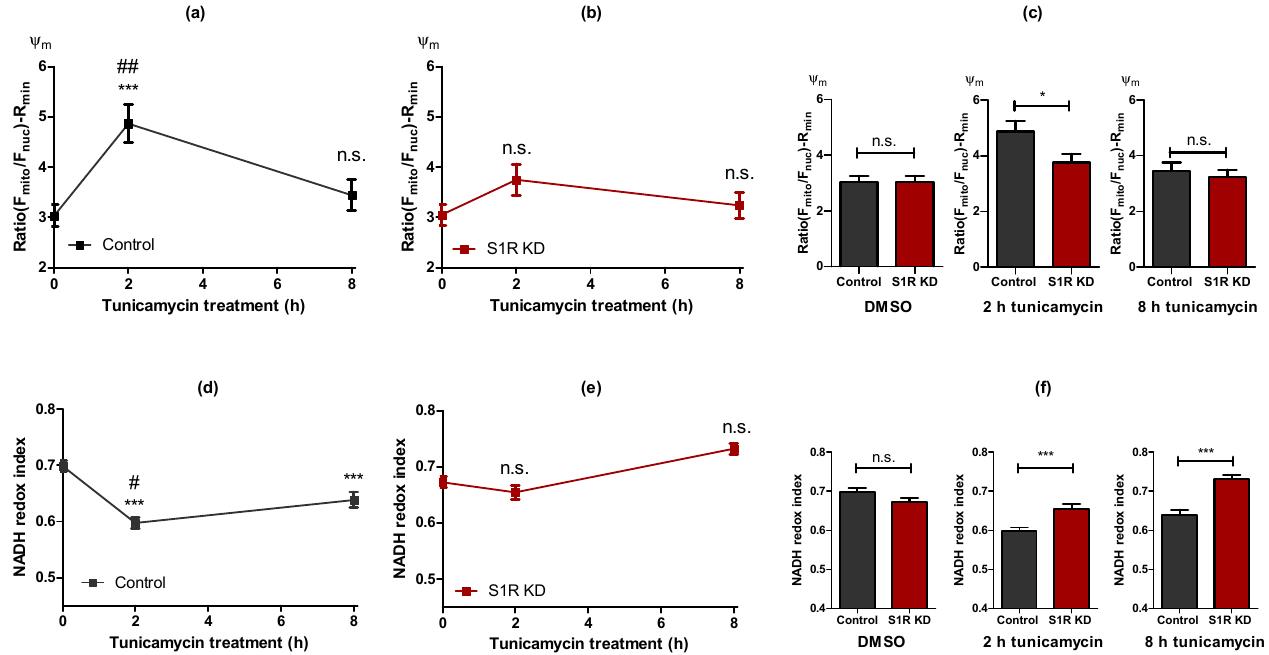
Figure 3. Alterations in the mitochondrial bioenergetic status are largely dependent on S1R during early ER stress. Time course of Ψ m after tunicamycin treatment, presented as mean ± SEM and assessed by the mitochondrial to nucleus TMRM fluorescence ratio in control SH-SY5Y cells ( a ) and in cells with S1R KD ( b ). Bar graphs represent MEAN ± SEM of Ψ m in control (black) and S1R KD (red) cells before tunicamycin treatment (left), after 2 h (middle), or 8 h (right) tunicamycin treatment ( c ). Time course of NADH redox index after tunicamycin treatment, presented as MEAN ± SEM and assessed NADH autofluorescence in control SH-SY5Y cells ( d ) and in cells with S1R KD ( e ). Bar graphs represent MEAN ± SEM of NADH redox index in control (black) and S1R KD (red) cells before tunicamycin treatment (left), after 2 h (middle), or 8 h (right) tunicamycin treatment ( f ). One-way ANOVA with Tukey’s multiple comparison test ( a , b , d , e ), ** * p < 0.001, ## p < 0.01 and # p < 0.05 (control 2 h tunicamycin against control 8hr tunicamycin), n.s.—not significant; unpaired t-test ( c , f ), ** * p < 0.001, * p < 0.05, n.s.—not significant; Ψ m : Control DMSO (57 cells/10 experiments), Control 2hr tunicamycin (31 cell/5 experiments), Control 8hr tunicamycin (42 cells/7 experiments), S1R KD DMSO (54 cells/10 experiments), S1R KD 2 h tunicamycin (29 cells/5 experiments), S1R KD 8 h tunicamycin (40 cells/7 experiments); NADH redox index: Control DMSO (208 cells/9 experiments), Control 2 h tunicamycin (203 cell/6 experiments), Control 8 h tunicamycin (143 cells/6 experiments), S1R KD DMSO (243 cells/9 experiments), S1R KD 2hr tunicamycin (111 cells/5 experiments), S1R KD 8hr tunicamycin (129 cells/6